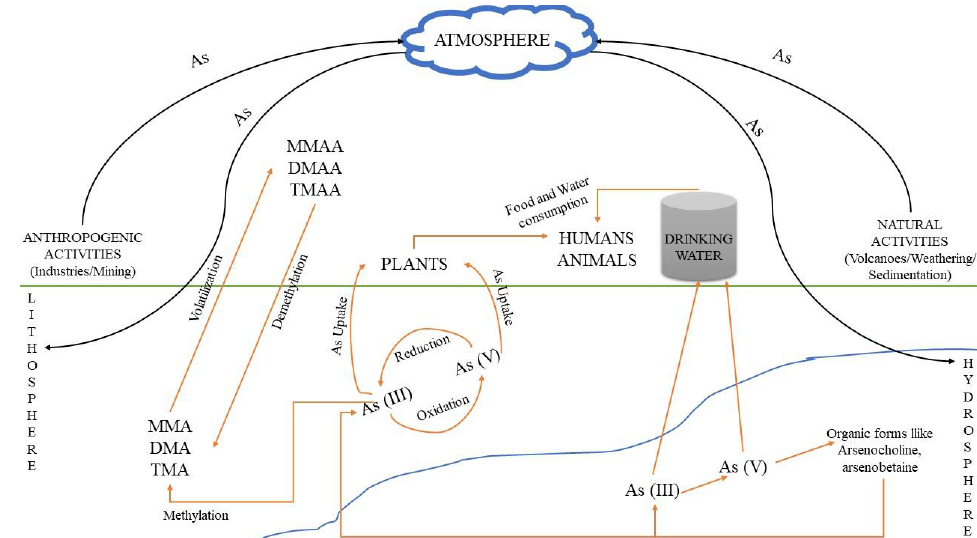
Figure 1. Pathways through which arsenic and its relevant compounds may enter the environment and contaminate soil, atmosphere and water. Human and natural activities result in As accumulation, mainly in soil and water, where As(V) and As(III) are interconverted via oxidation and reduction bio/reactions. The respective methylated products can be produced from As(III) species, i.e., MMA, DMA and TMA, resulting in the formation of MMAA, DMAA and TMAA chemical compounds, mainly through volatilization, while the reverse process occurs through demethylation.